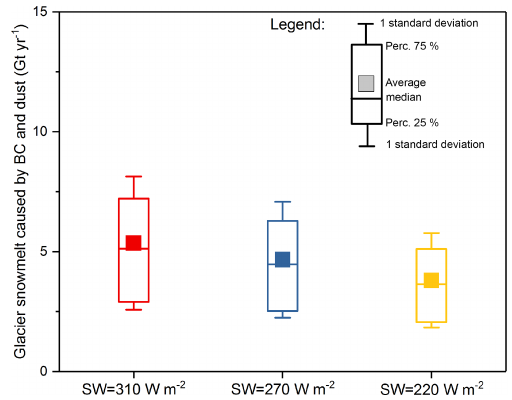
Figure 9. Estimates of total glacial snowmelt based on daily snowmelt caused by BC and dust for shortwave radiation at 220, 270, and 310Wm − 2 , respectively. The days of daily temperature above 0 ◦ C value is 100 ( ±